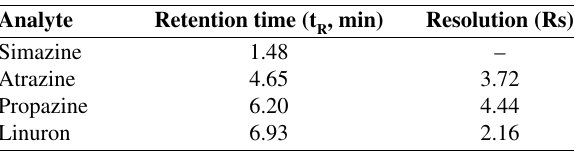
Table 1. The retention time (t compounds after HPLC analysis Analyte Retention time (t